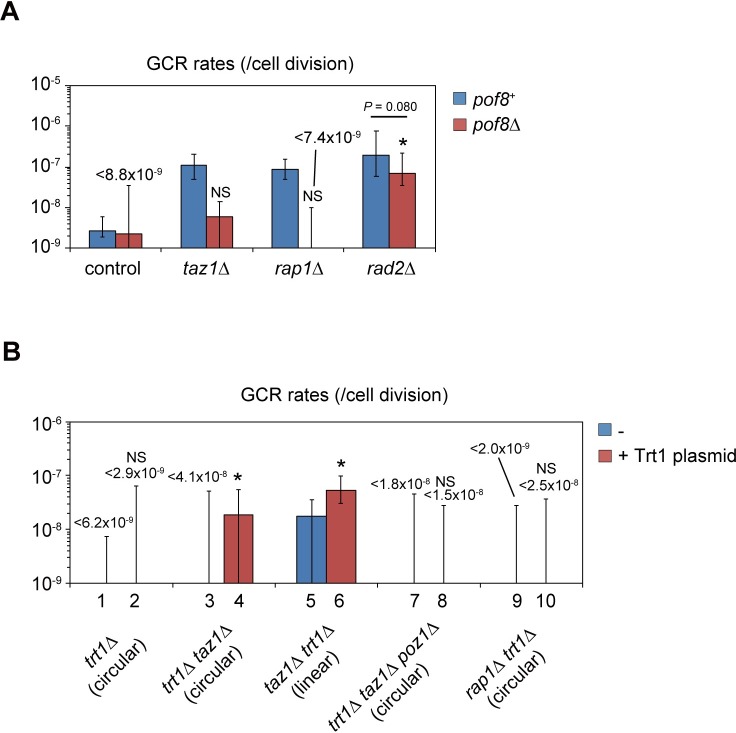
Telomerase activity is essential for frequent GCRs in taz1Δ and rap1Δ strains.(A) GCR rates of wild-type, taz1Δ, rap1Δ, and rad2Δ strains in the presence or absence of pof8+. (B) GCR rates of trt1Δ strains in the presence or absence of a pREP1-trt1+ plasmid (Trt1 plasmid). The GCR assay was performed in YES media, in which the nmt1 promoter in the plasmid has a moderate activity [69]. Asterisks and NS represent significant differences (P < 0.05 and P>0.05) from the wild type strain, respectively. P-values were obtained by the two-tailed Mann–Whitney test.